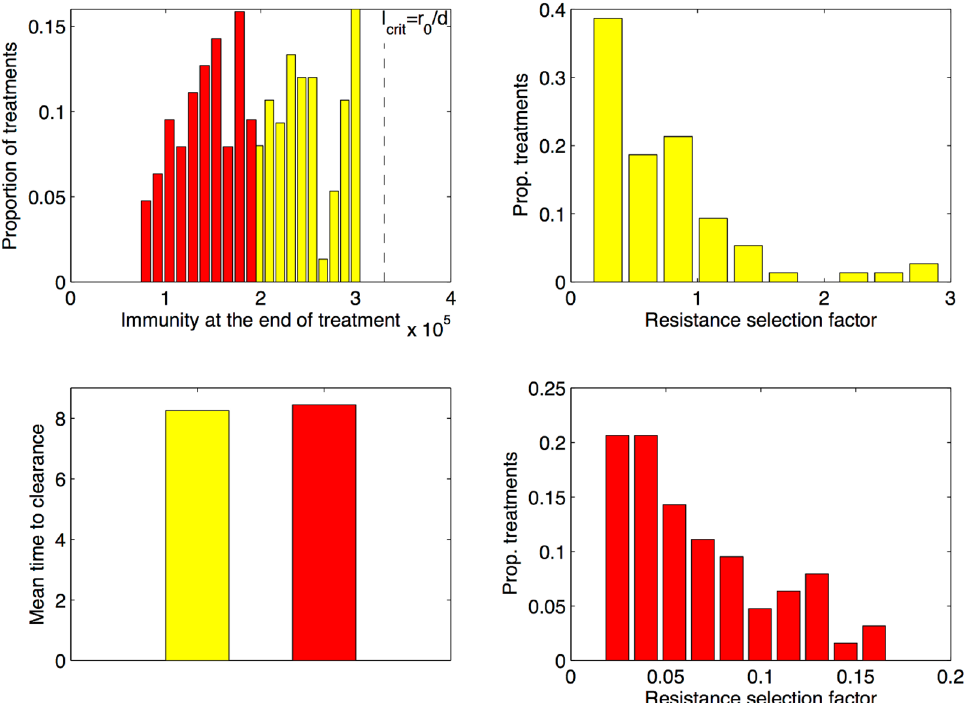
Fig 6. Details from optimal moderate treatments in the classical case, for high cost of resistance. We compare infection outcomes obtained from selected dose-delay combinations (A m , τ 1 ) below MSW in scenario G of Fig 5 where the cost of resistance is c = 0.1. The treatment combinations satisfying only the duration criterion (yellow) display higher immunity levels at the end of infection than treatment combinations satisfying both the low duration and low immunopathology criteria (red). The resistance selection factor (relative to no treatment) is lower in scenarios of low immunopathology. However, as shown in the top-right panel, in about 75% of the other moderate scenarios (yellow), the resistance selection factor is still below 1, evidently marking an overall reduction compared to no-